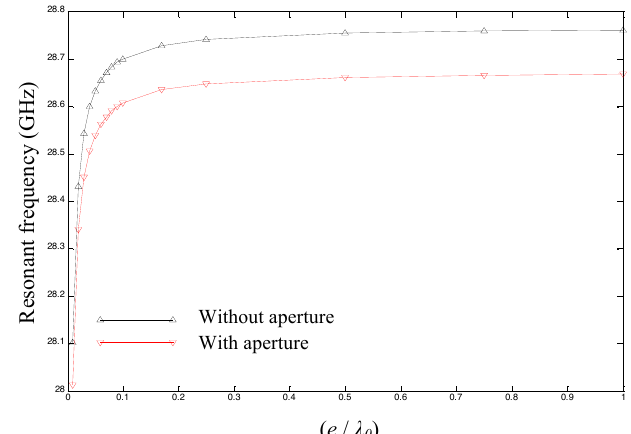
Figure 2: Resonant frequency of the superconducting microstrip antenna with and without a rectangular aperture in the ground plane against normalized thickness of patch.